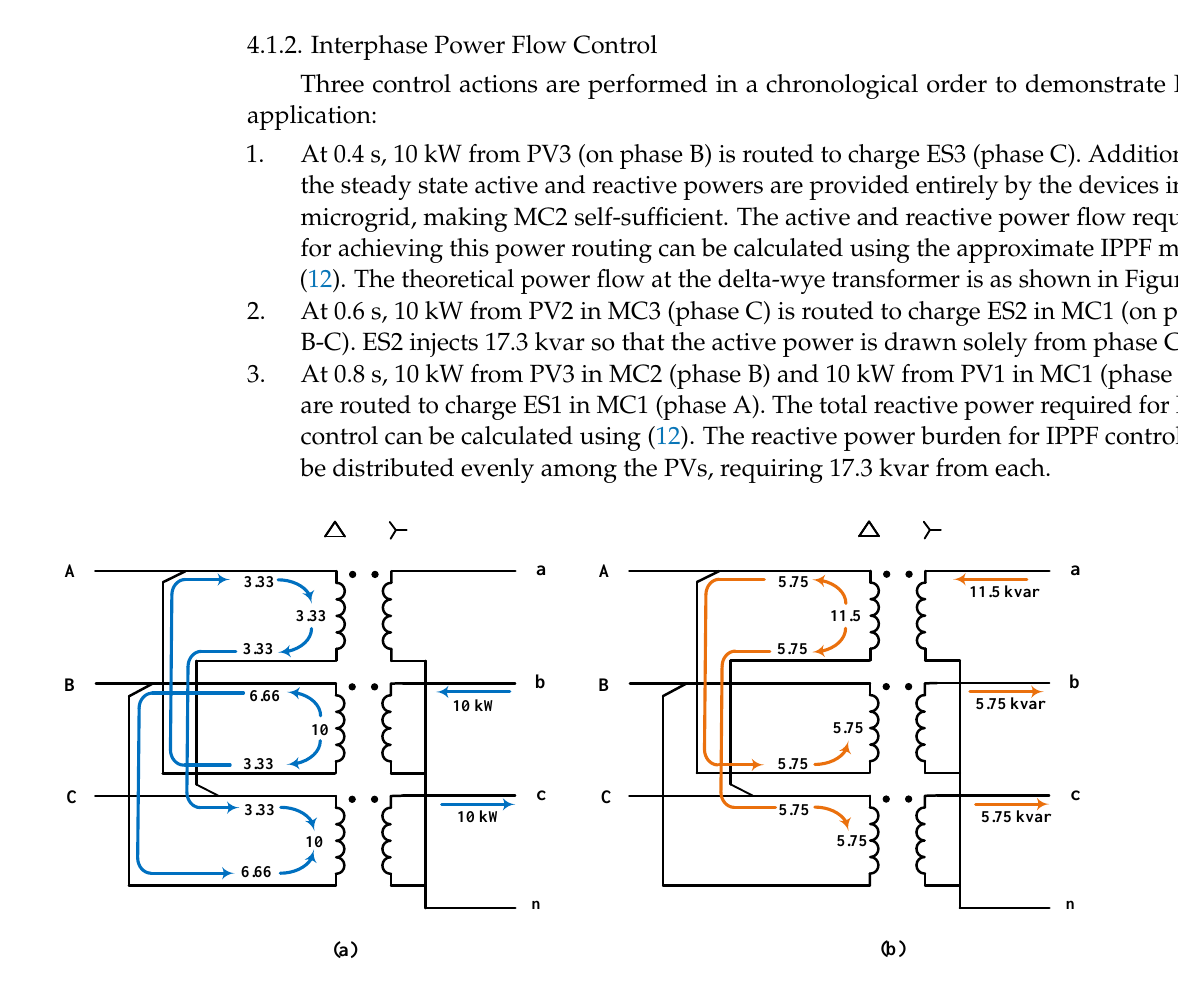
Figure 11. Theoretical interphase active ( a ) and reactive ( b ) power flow at the delta-wye transformer (Dy1) of MC2 as a result of routing 10 kW from phase B to C at the secondary circuit. The active and reactive power required for IPPF control are provided solely from the secondary